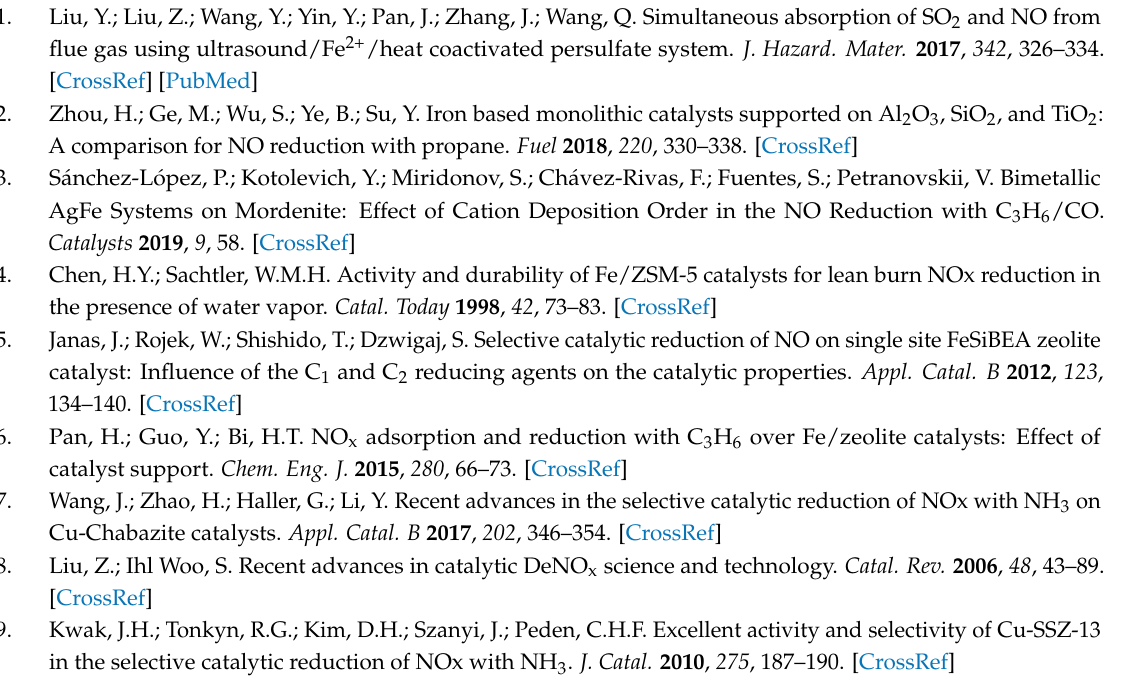
Figure S1: XPS spectra of Fe 2p of Fe/Beta catalysts prepared by different methods; Figure S2: UV-vis spectra of Fe 2 O 3 ; Figure S3: UV-vis spectra with deconvolution method of Fe/Bate catalysts; Figure S4: Apparent TOF with total Fe at 200 ◦ C on Fe/Bate catalysts; Figure S5: XRD diffractograms of the fresh and aged Fe/Bate catalysts; Figure S6: UV-vis spectra with deconvolution method of the fresh and aged Fe/Bate catalysts; Table S1: Percentage of Fe species over the fresh and aged Fe/Bate